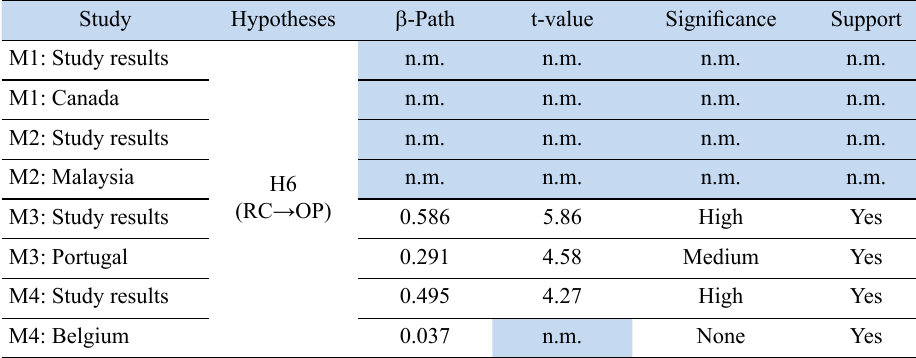
Table 7. Comparative summary results for Hypothesis